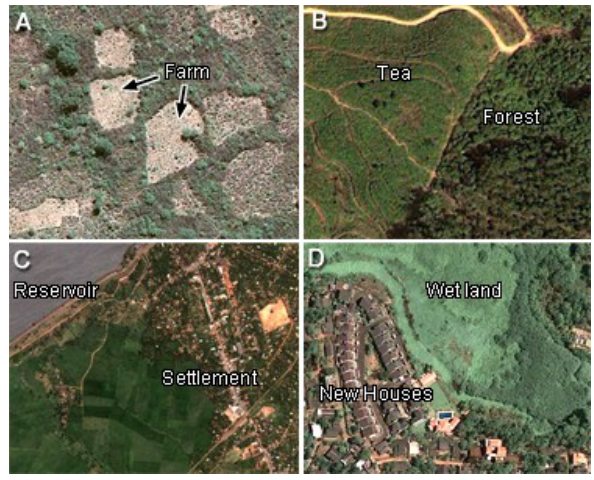
Figure 1. Major causes of deforestation in Sri Lanka; A – traditional cut and burn farms, B – large scale plantations, C – new agriculture settlements, D – filling wet lands for housing. See approximate image locations in figure